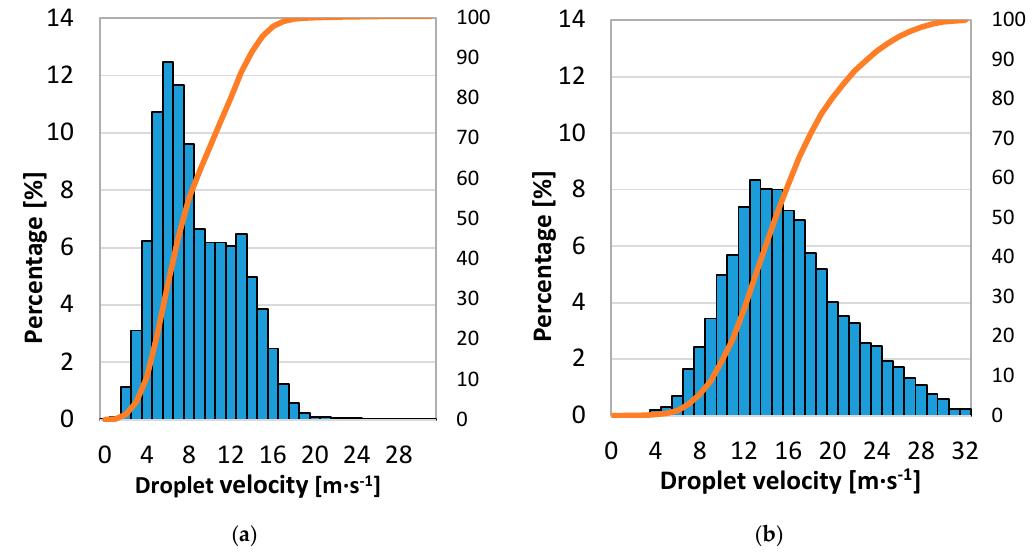
Figure 7. Droplet diameter distribution for experiments E9 and E10, identical nozzle, identical water flowrate, air pressure 1.5 bar left ( a ), air pressure 3.0 bar right ( b ), cumulative percentage orange line.